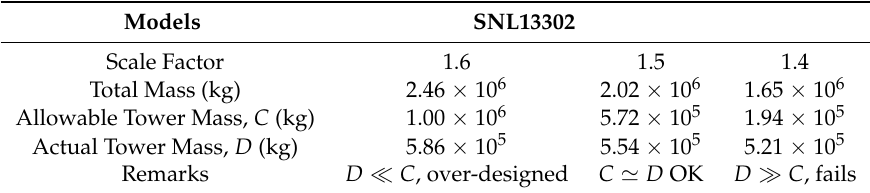
Table 8. Alternative models and evaluations against heave motion